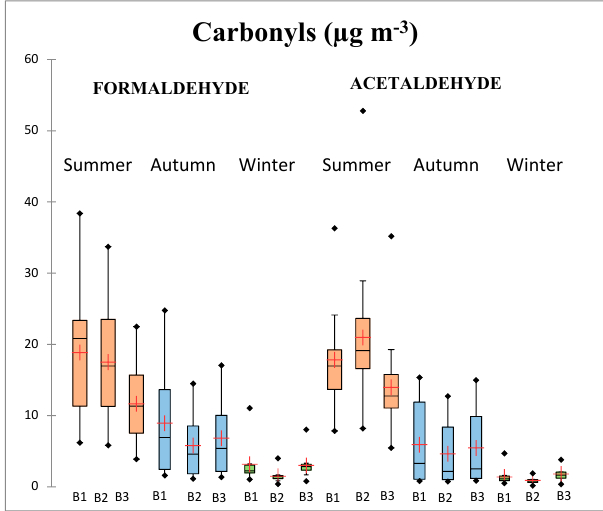
Figure 3. Diurnal, seasonal variation, and parametric statistics for formaldehyde and acetaldehyde in the study site. B1: Morning sampling period (09:00–10:30 h); B2: Midday sampling period (12:00–13:30 h); and B3: Afternoon sampling period (15:00–16:30 h). The red crosses correspond to the means. The central horizontal bars are the medians. The lower and upper limits of the box are the first and third quartiles, respectively. The points are the minimum and maximum values for each station. The horizontal width of the box has no statistical significance; it is only for better